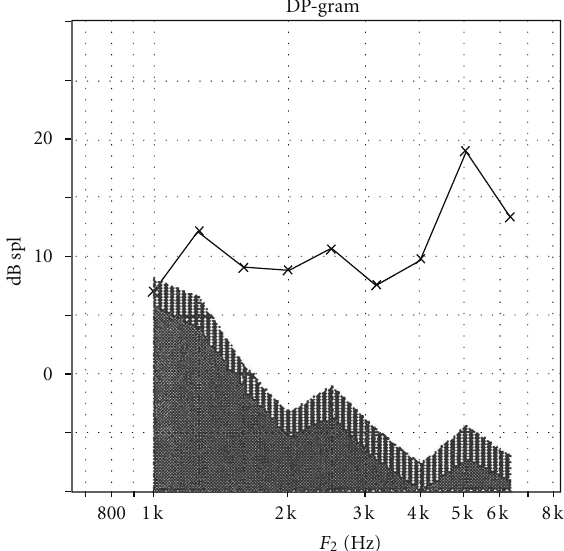
Figure 7: Normal auditory brainstem response morphology in a patient with auditory